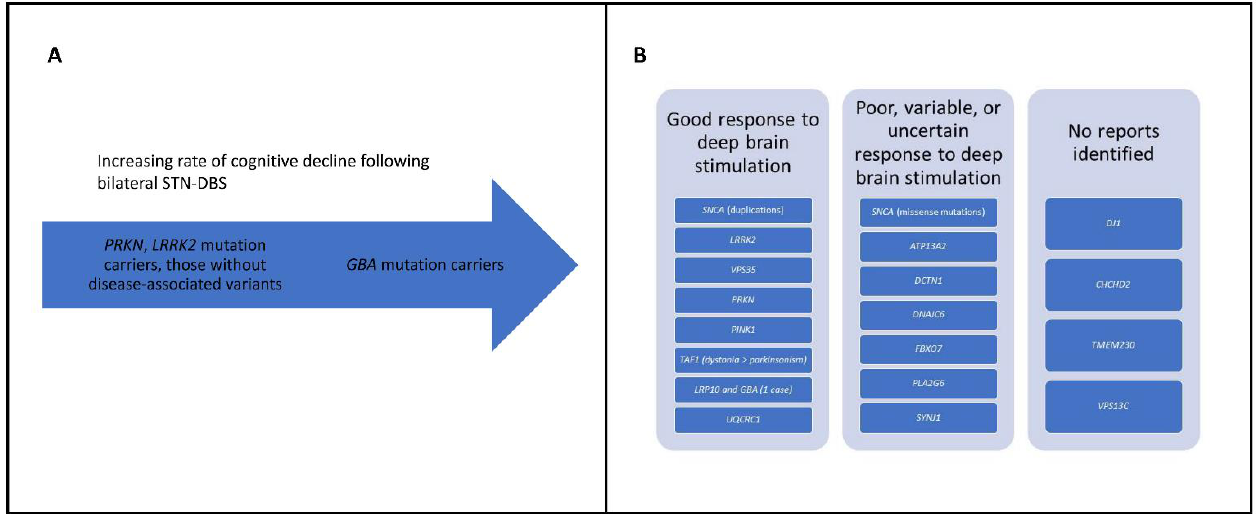
Figure 1. ( A ) Increasing cognitive decline in GBA carriers versus PRKN , LRRK2 , and those without disease-associated variants. ( B ) Outcome of deep brain stimulation stratified according to Parkinson’s disease monogenic forms.